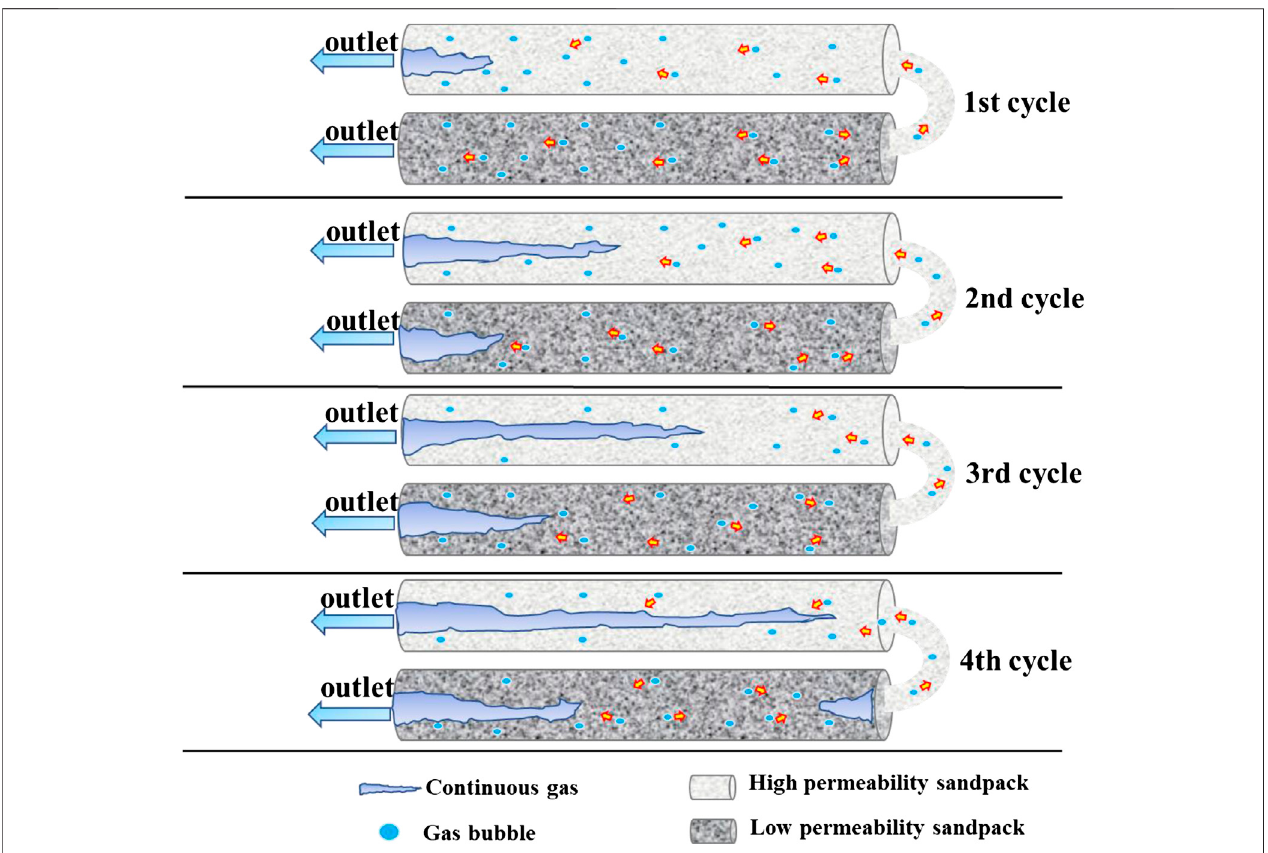
FIGURE 15 | Diagram of dual sandpack N 2 huff-n-puff production